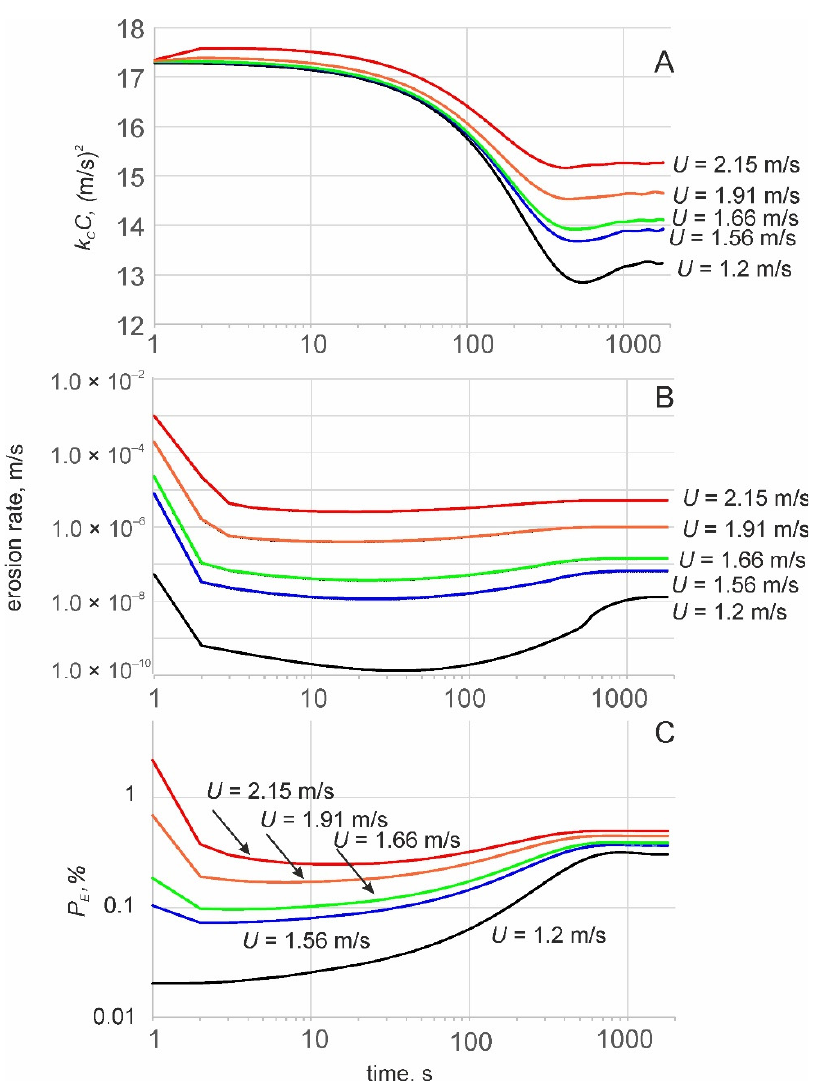
Figure 4. Change through time in calculated specific soil cohesion force k C C ( A ), erosion rate E ( B ) and the percentage of the area occupied by erodible soils after the armoring–loosening cycles P E ,% ( C ) for different flow velocities. The initial k C is 17, the parameter of loosening λ = 0.001, and other parameters were obtained from plot